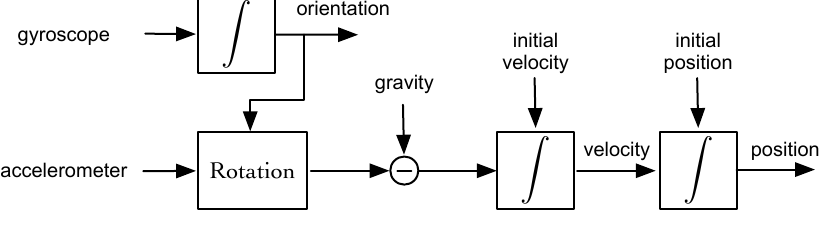
Figure 8. Strapdown navigation